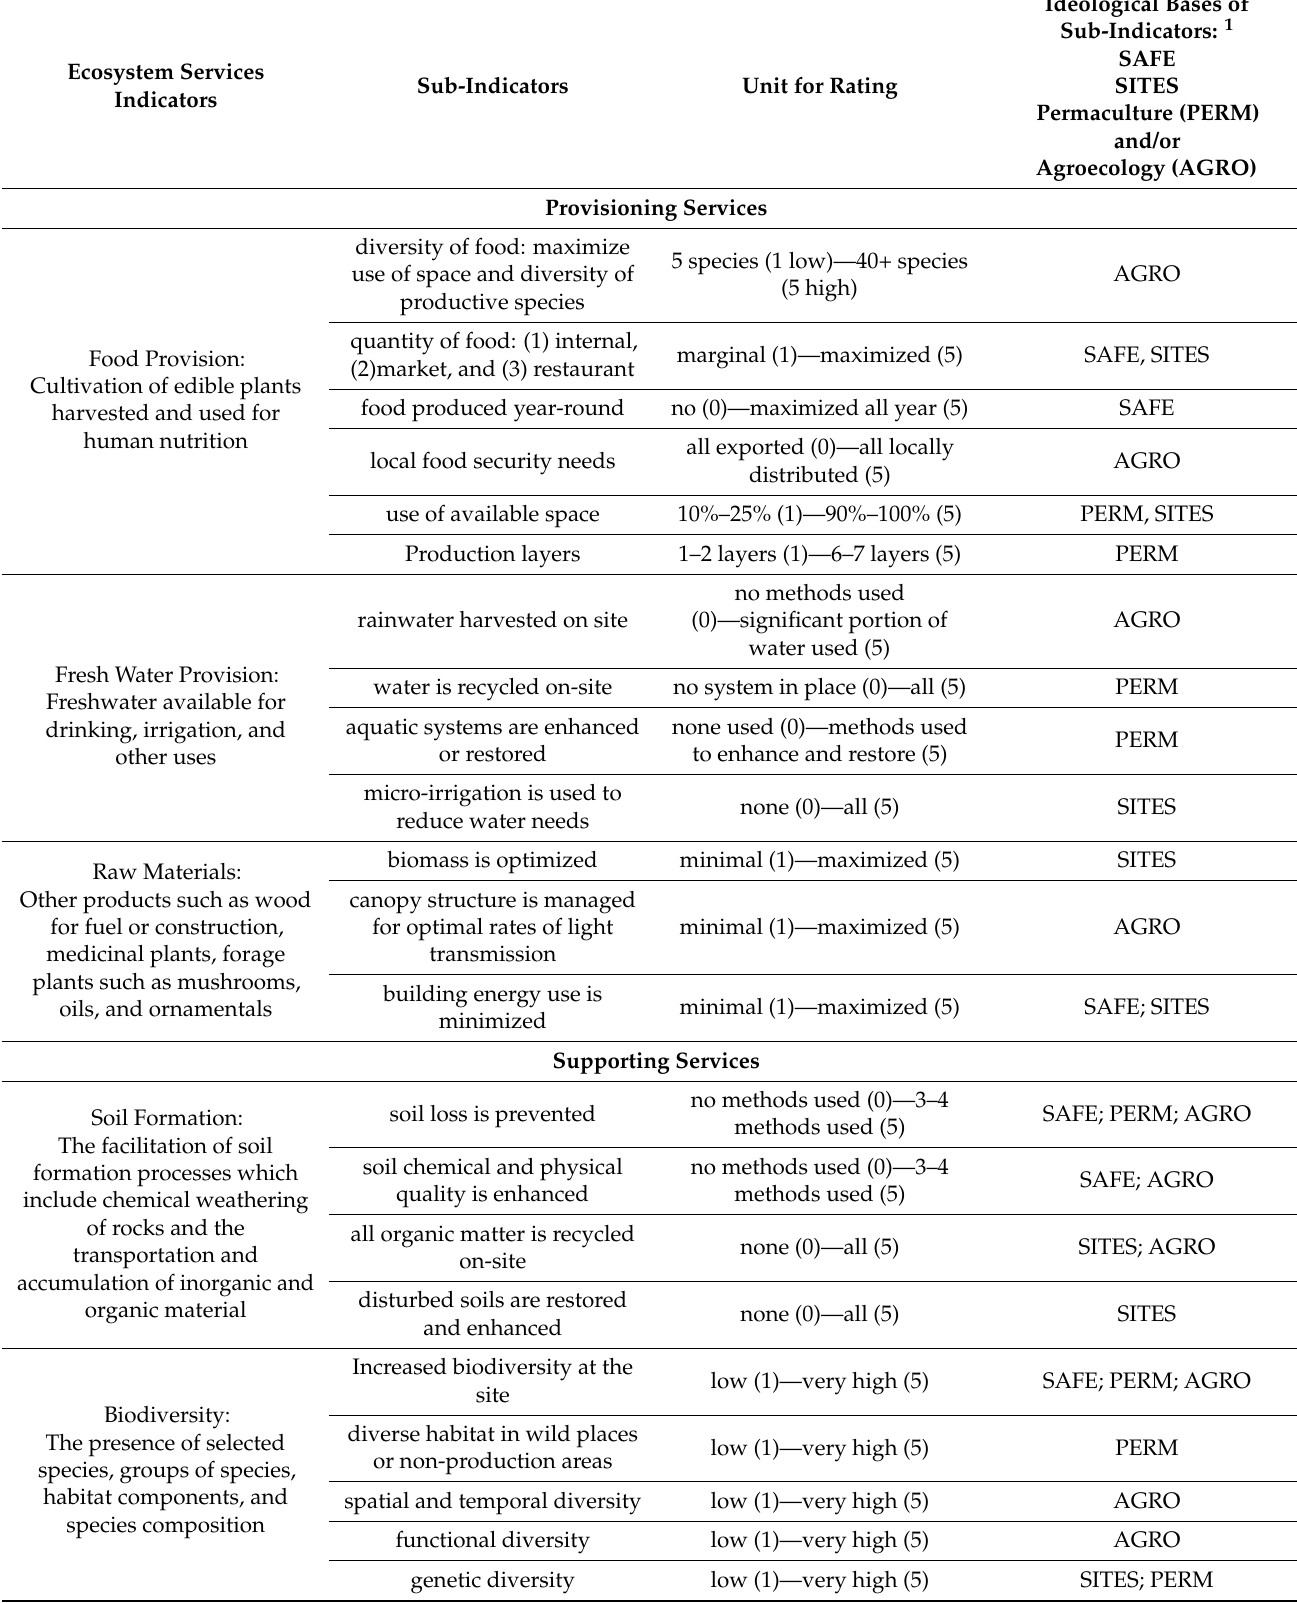
Table 2. Ecosystem service-based sustainability criteria and indicators and the rubric used in the P+